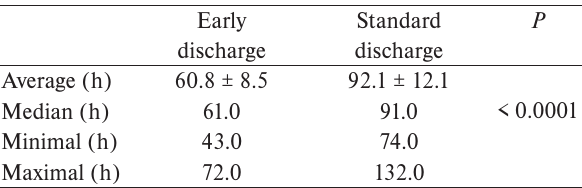
Table 3. Length of hospital